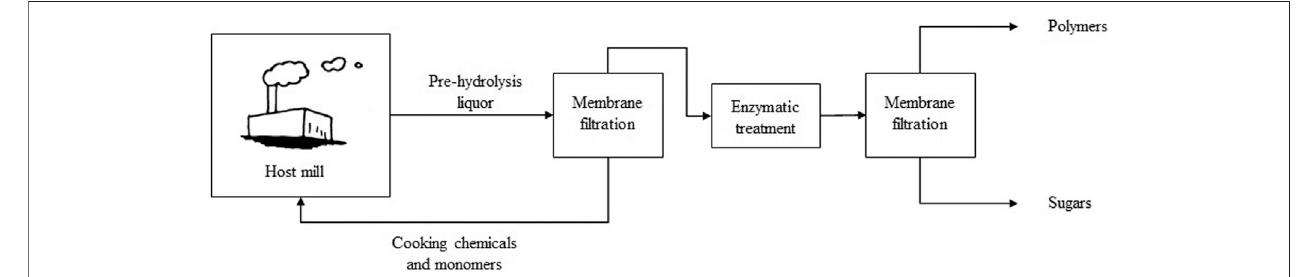
FIGURE 1 | Schematic description of the Ecohelix process for LCC